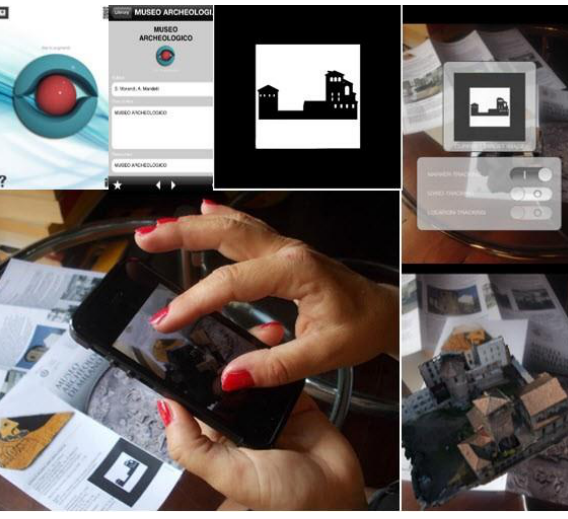
Figure 9. The 3D model of the site and towers managed by